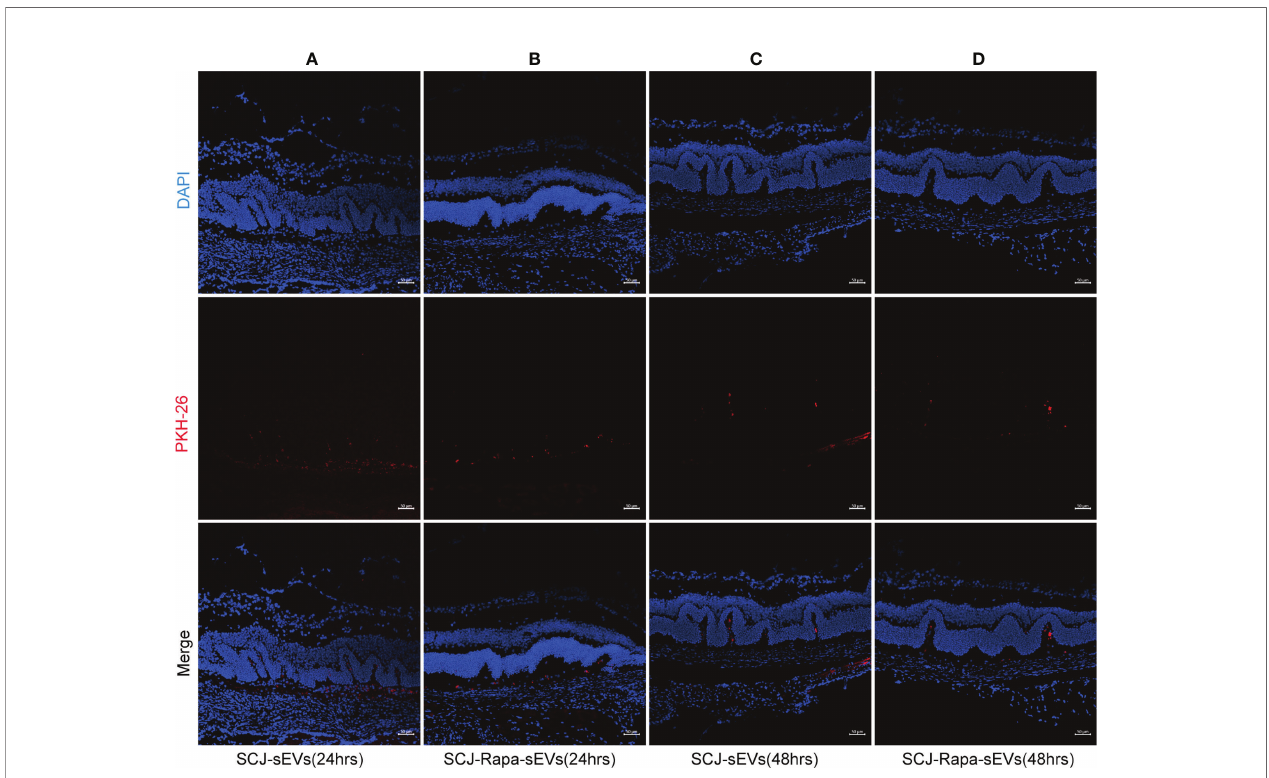
FIGURE 4 | Trace of sEVs. Distribution of sEVs labeled with PKH-26 in the retina was observed at 24 h and 48 h after subconjunctival injection. 24h after the injection of sEVs (A) and Rapa-sEVs (B) , fl uorescence was detected in the retina. A mild reduction in red fl uorescence was observed 48 h after the injection of sEVs (C) and Rapa-sEVs (D)